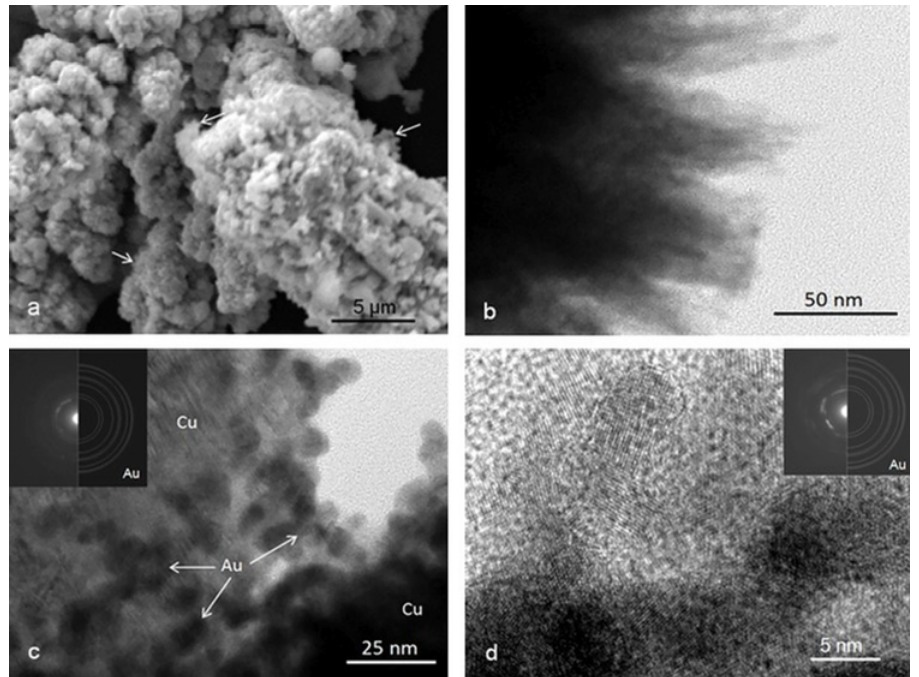
Fig 2. SEM (a) and TEM (b-d) images of 1.0% Au/Cu